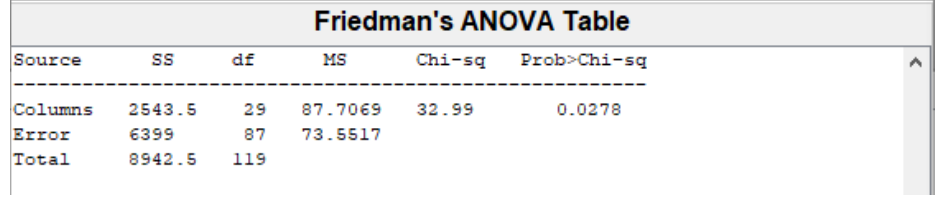
Figure 4. Friedman’s test results.